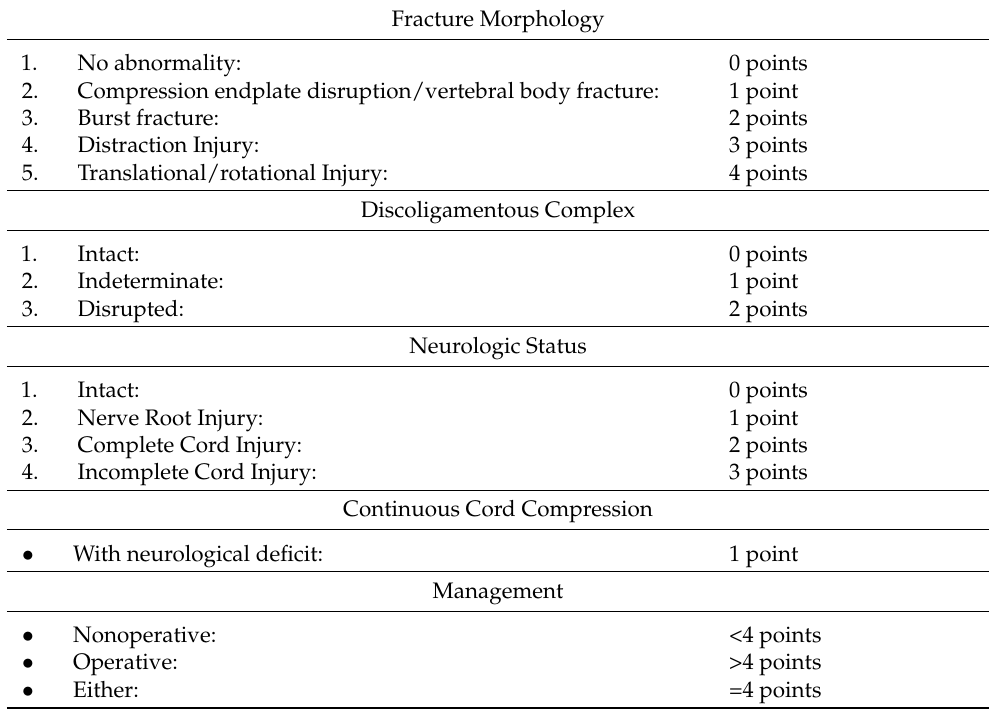
Table 4. The Subaxial Cervical Spine Injury Classification System